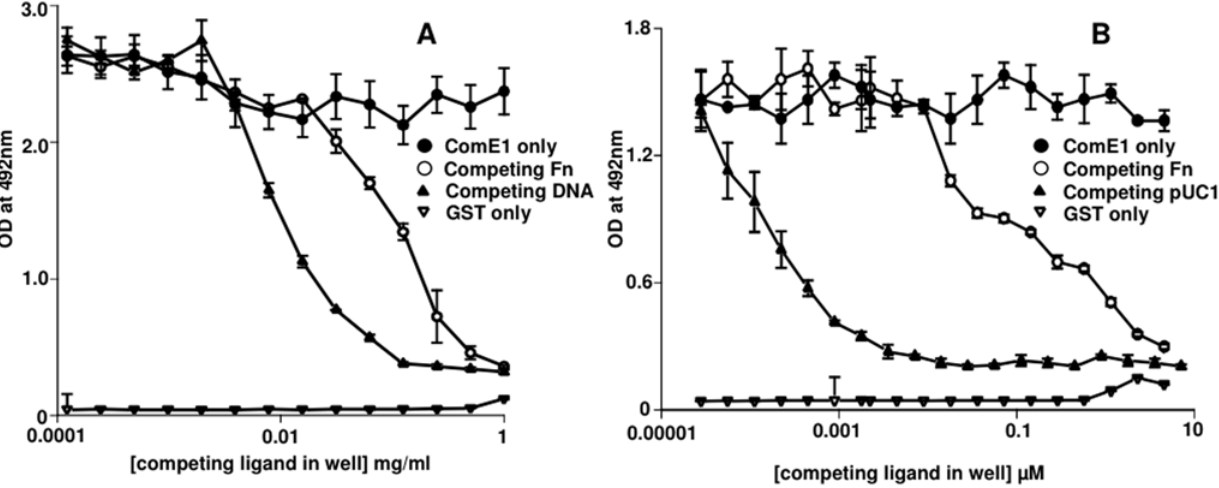
Figure 1. Binding of DNA to ComE1. (A) Inhibition ELISA to determine the capacity of Fn or genomic DNA isolated from P. multocida to block the binding of rGST-ComE1 from P. multocida to immobilised human serum Fn. The competing ligands were added at concentrations ranging from 1 mg/ml to 0.1 m g/ml. (B) Inhibition ELISA to determine the capacity of Fn or pUC19 DNA to block the binding of rGST-ComE1 from P. multocida to immobilised human serum Fn. Equimolar concentrations of Fn of pUC19 DNA were used to compete with immobilised Fn for binding to rGST-ComE1. Results are presented as the mean 6 SEM of quadruplicate wells and are representative of at least three experiments. The values for rGST-ComE1 refer to the binding of this protein to Fn-coated wells with no competing ligands.